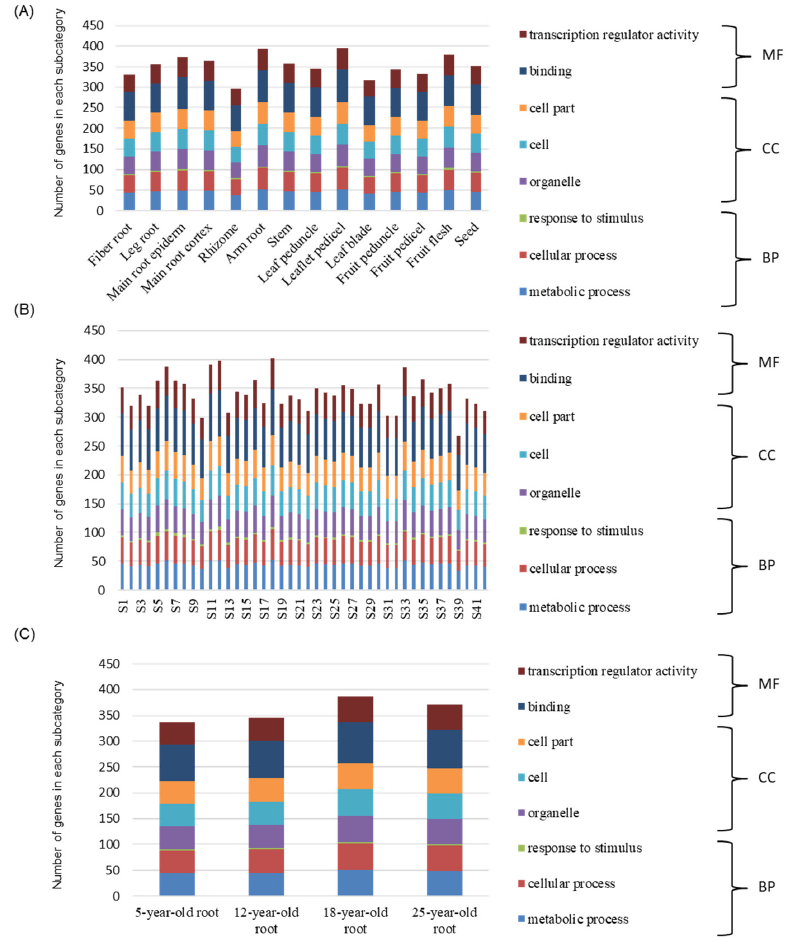
Figure 5. Variation of the functional categories of the PgWRKY genes by Gene Ontology (GO) . ( A ) Variation of the functional categories of the PgWRKY genes among 14 tissues of four-year-old ginseng; ( B ) Variation of the functional categories of the PgWRKY genes among the 42 farmers’ cultivars roots of ginseng; ( C ) Variation of the functional categories of the PgWRKY genes among different aged roots.